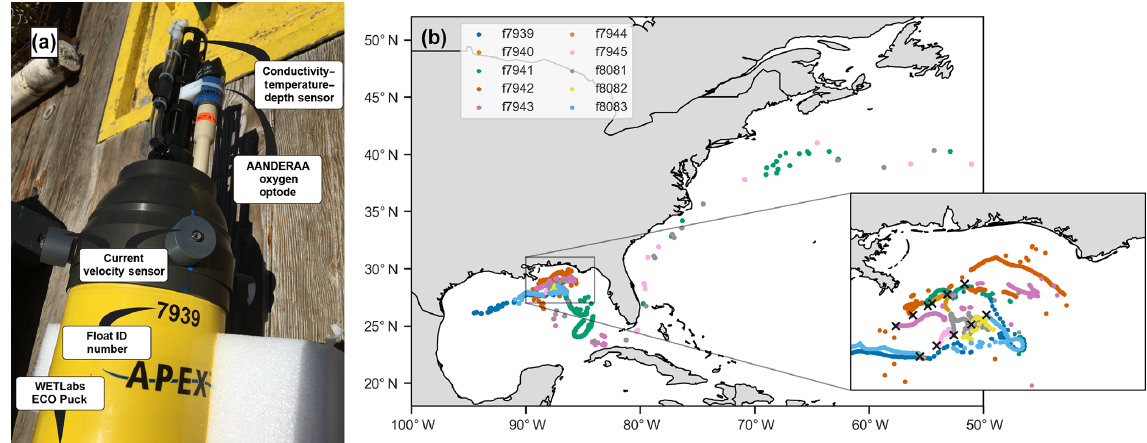
Figure 1. (a) Photo of float f7939 with the sensors labeled. (b) Map of the 10 deployment stations (black crosses in inset) and float